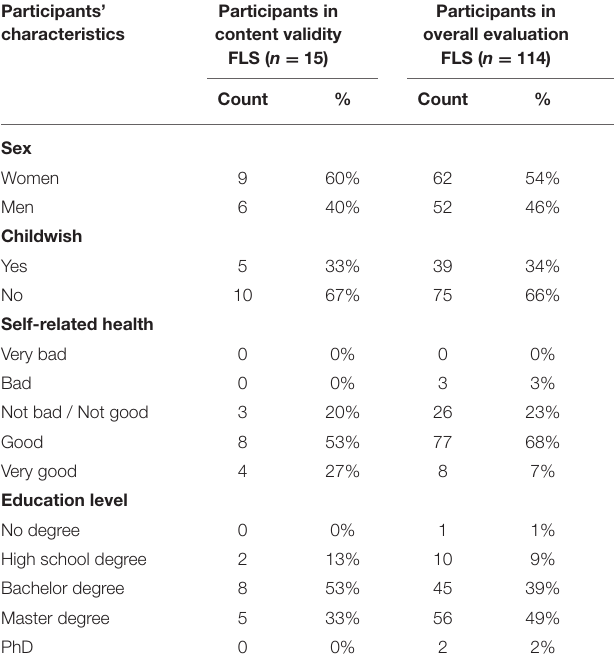
TABLE 3 | Participants’